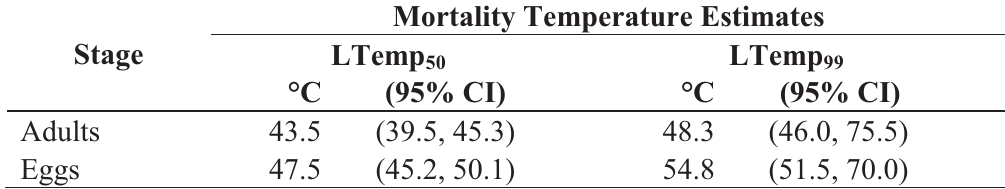
Table 1. Lethal Temperature (LTemp) estimates for 50 and 99% mortality of bed bug adults and eggs.